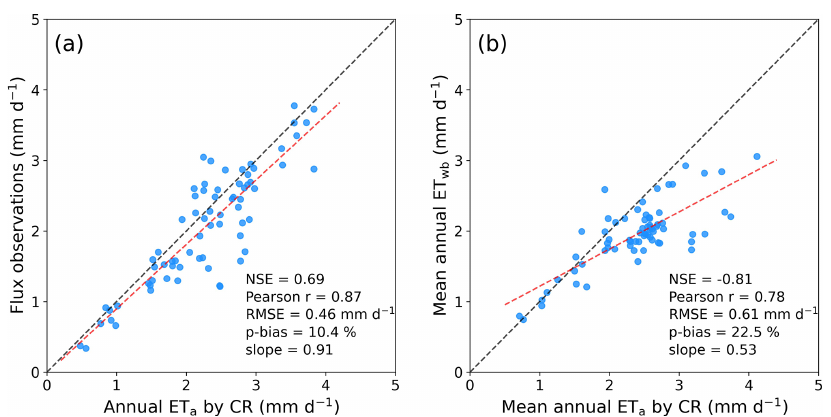
Figure 2. The 1 : 1 comparison between the CR ET a estimates with α e = 1 . 15 and (a) the annual FLUXNET2015 observations and (b) the mean annual ET wb of the 71 CAMELS basins for 1998–2014.